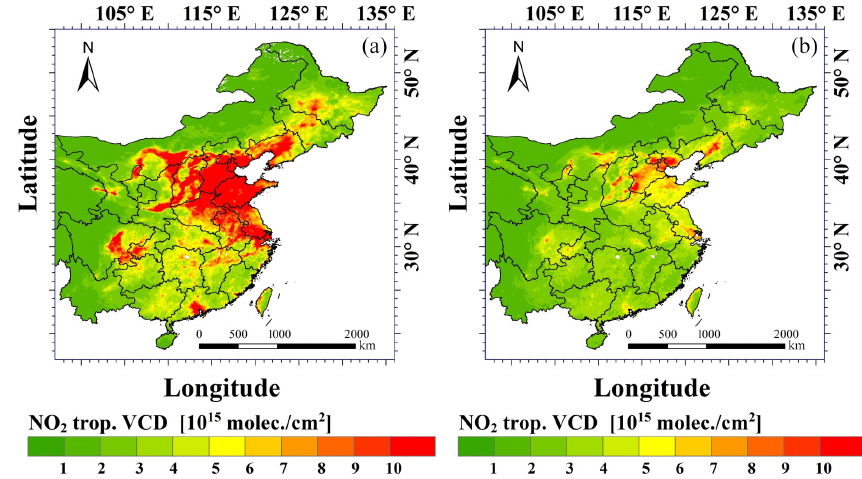
Figure 4. NO 2 tropospheric vertical column densities derived from TROPOMI data over east China, averaged over 30d before (a) and after (b) the 2020 Spring Festival. The 2020 Spring Festival was on 25 January 2020 and thus the 30d period before started on 26 December 2019 and the 30d period after ended on 24 February